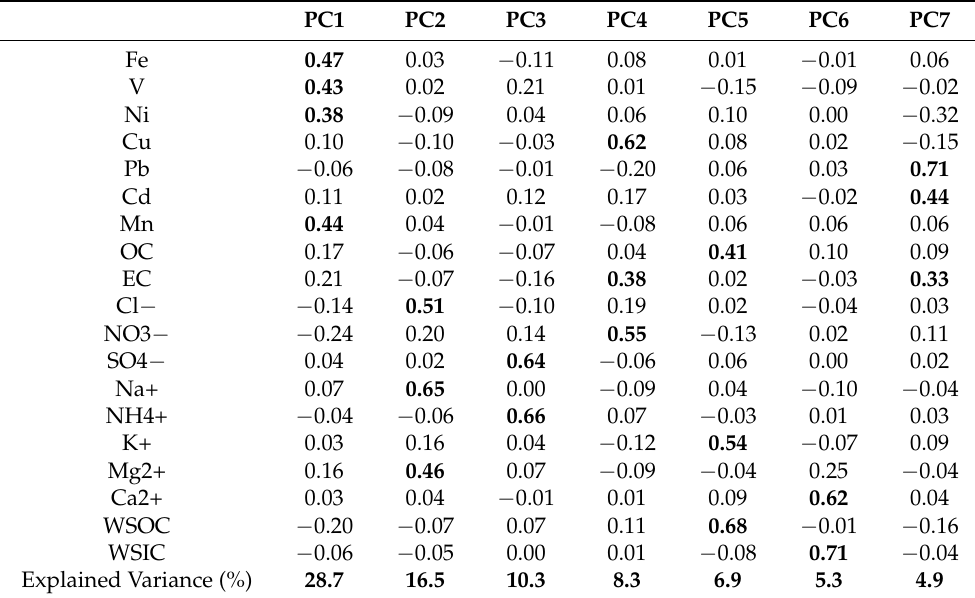
Table 2. Principal Component Analysis (PCA) Loading values. Values larger than 0.23 are highlighted in